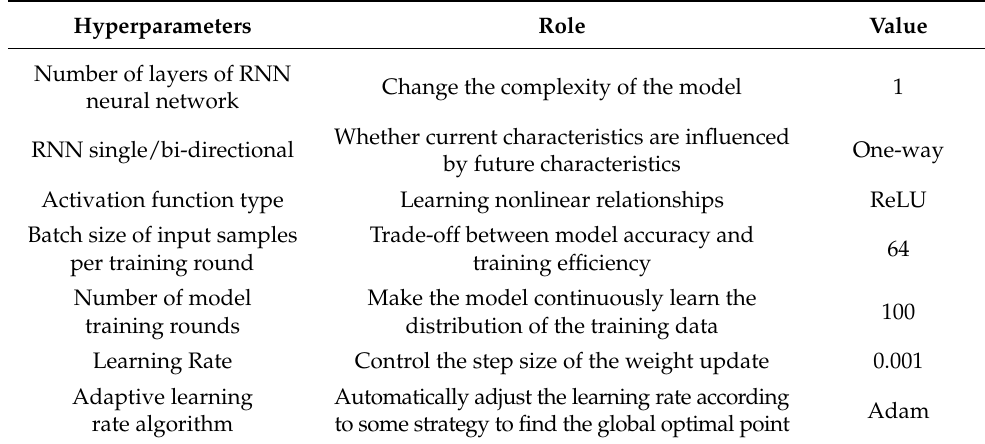
Table 5. encoder–decoder architecture hyperparameter